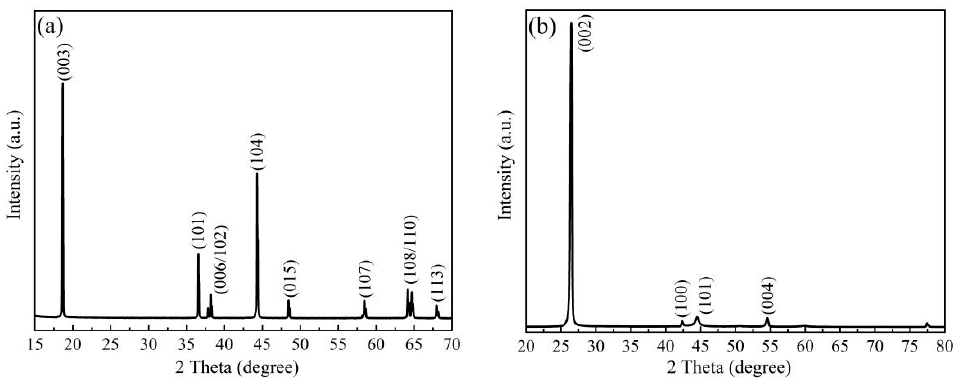
Figure 2. X-ray diffraction spectrum of ( a ) NCM523 and ( b ) graphite.